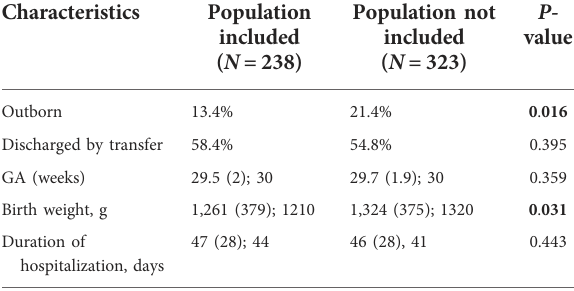
TABLE 1 Comparison of the population included in the study and the population excluded from the study.